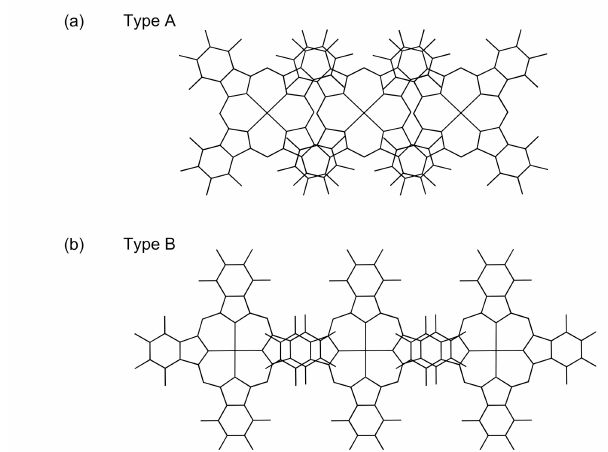
Figure 2. Two types of π - π overlaps between the M III (Pc)L 2 units: ( a ) overlap involving two peripheral benzene rings per unit (type A); ( b ) overlap involving one peripheral benzene ring per unit (type